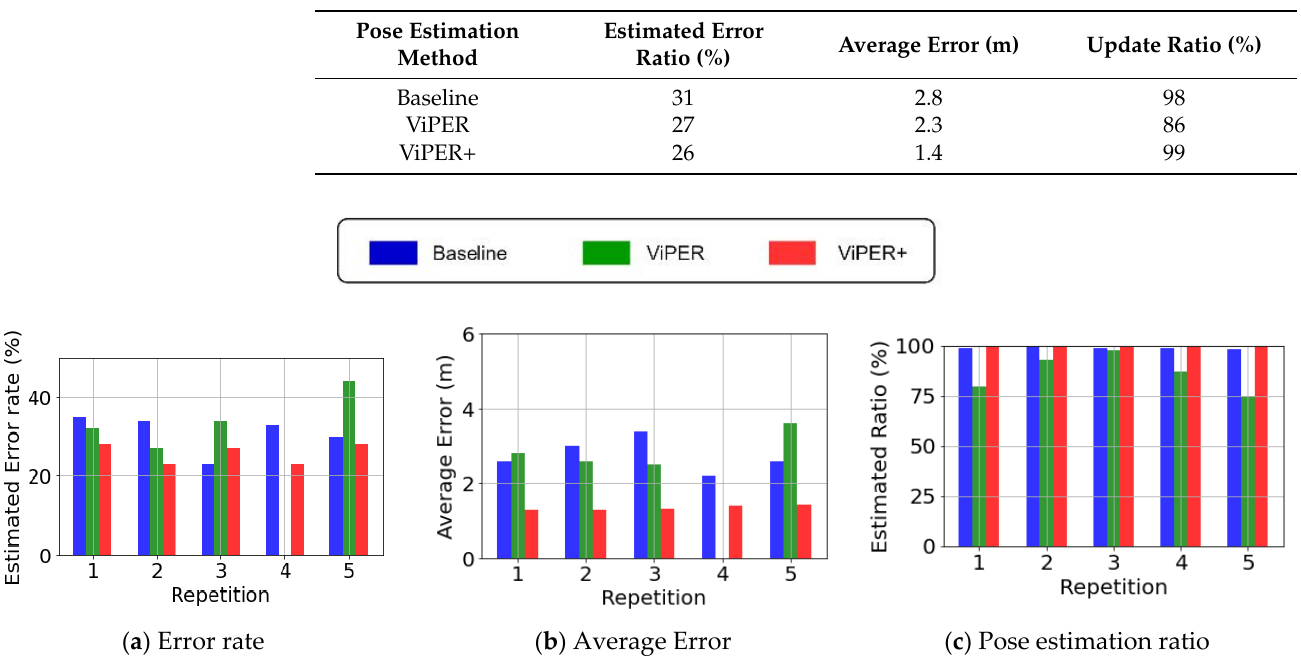
Figure 9. Results of vehicle tracking for scenarios with a blocking object. Using ViPER reduces the error rate in the pose estimation of the vehicle compared to the other two methods.